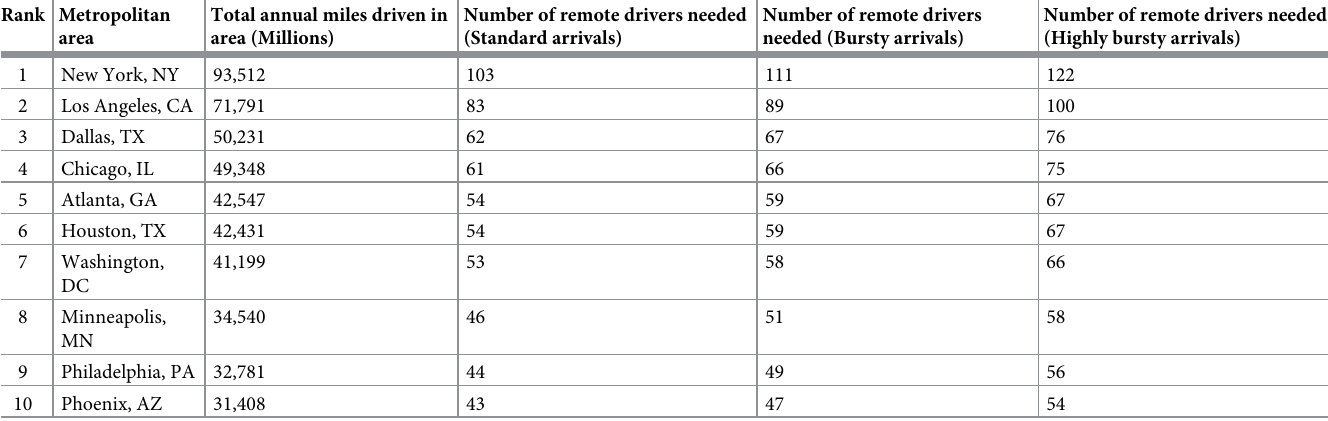
Table 1. Estimated number of remote drivers needed during peak travel time under three arrival